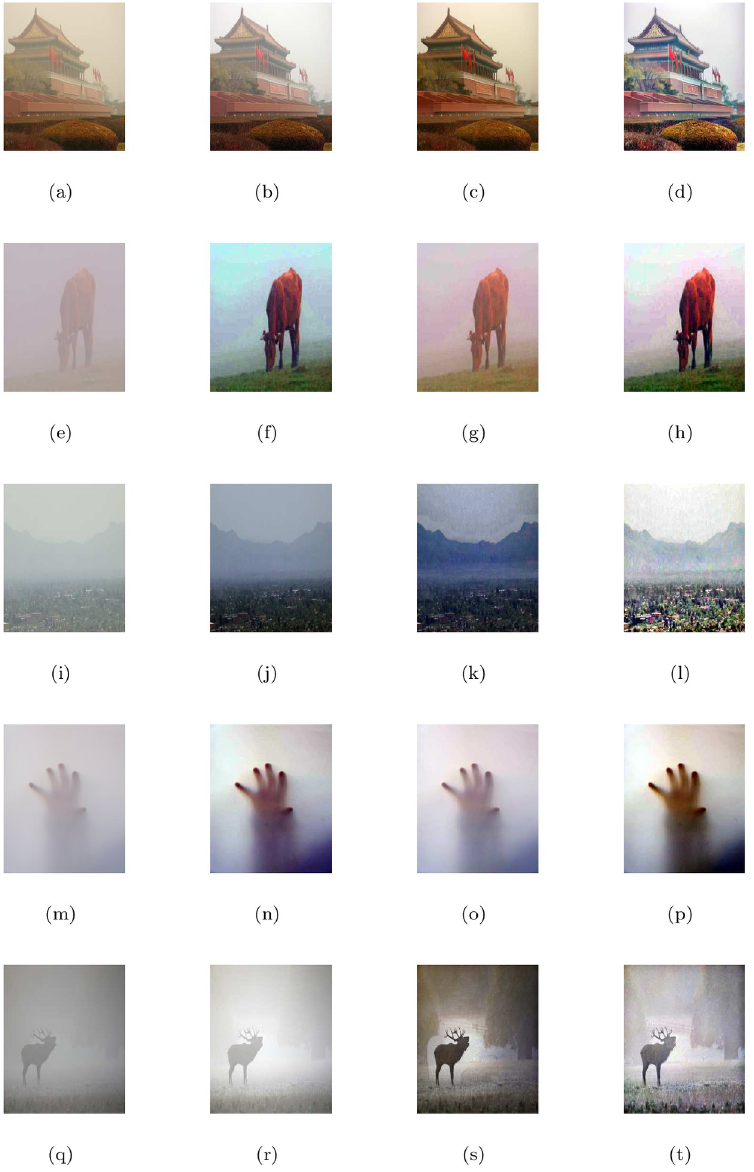
Fig 5. De-hazing performance of the proposed model (M3) in comparison with M1 and M2. From L to R columns represent the given degraded images, M1, M2 and M3 results, respectively.